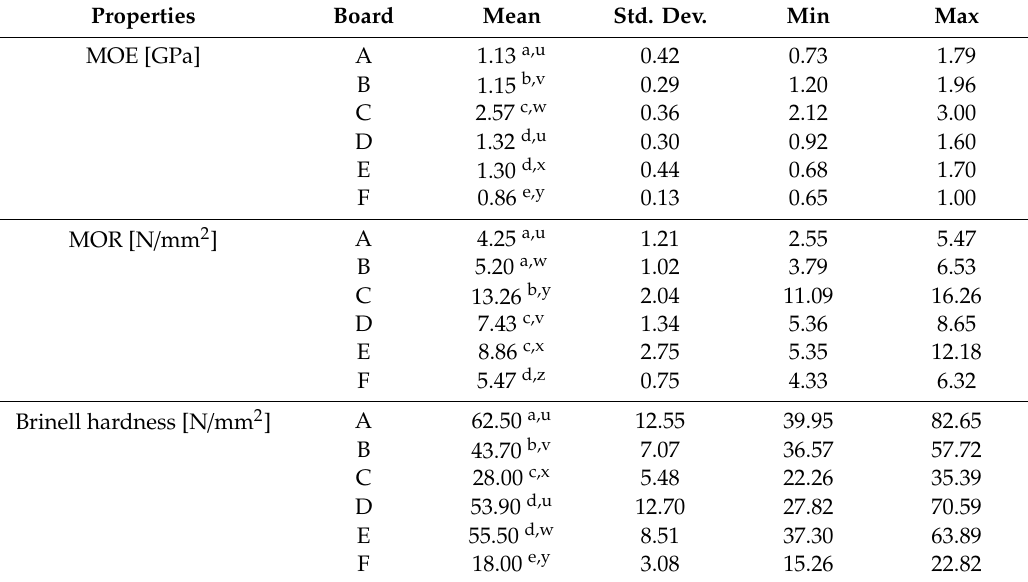
Table 4. Mechanical properties of the hazelnut, walnut, and spruce particle